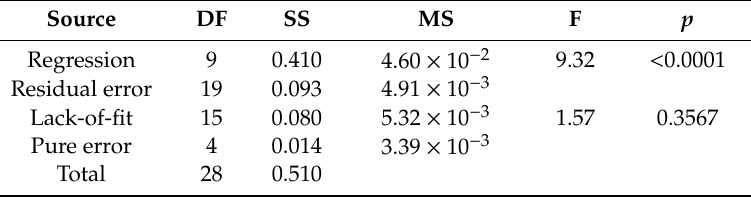
Table 4. ANOVA results for the reduced model described by Equation (7). DF denotes the degrees of freedom, SS the sum of squares, MS the mean squares, F the F -value, and p the p -value.